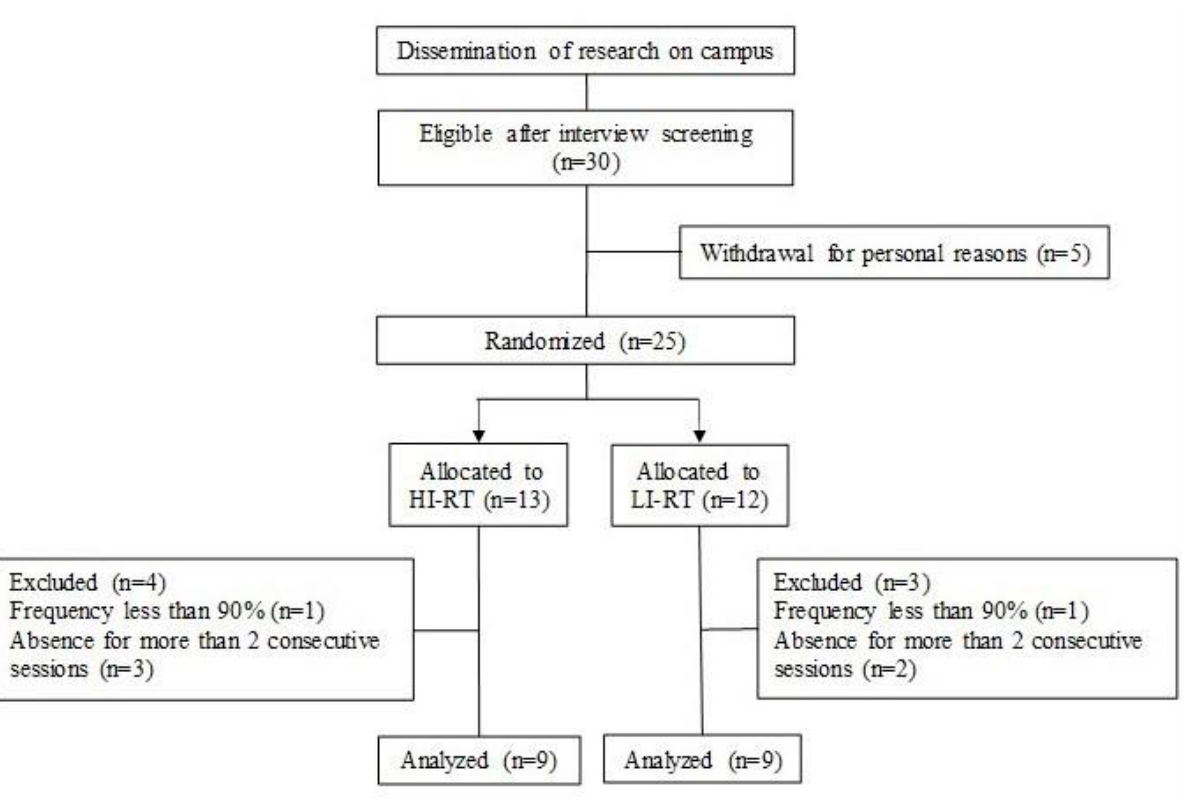
Figure 1. Flow diagram of participants in the study.